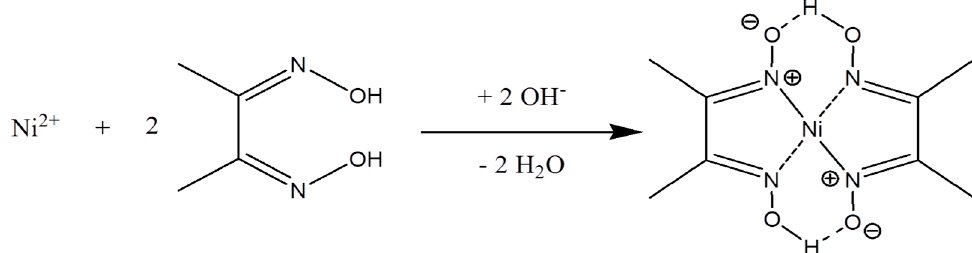
Figure 2. Schematic illustration of the metal-chelate complex formation [46].